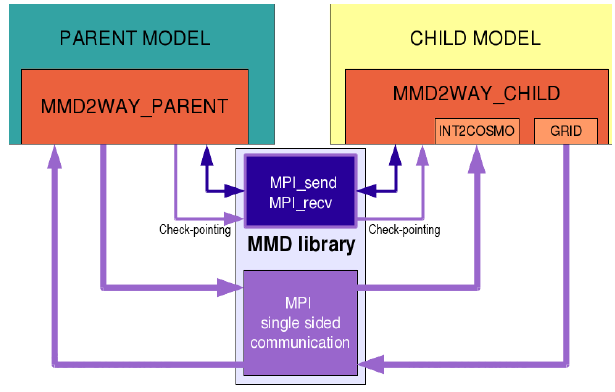
Figure 2. Illustration of the communication managed by MMD be- tween a parent and a child model. Dark violet colours indicate data flow during the initial phase, while purple indicates the data flow during the integration